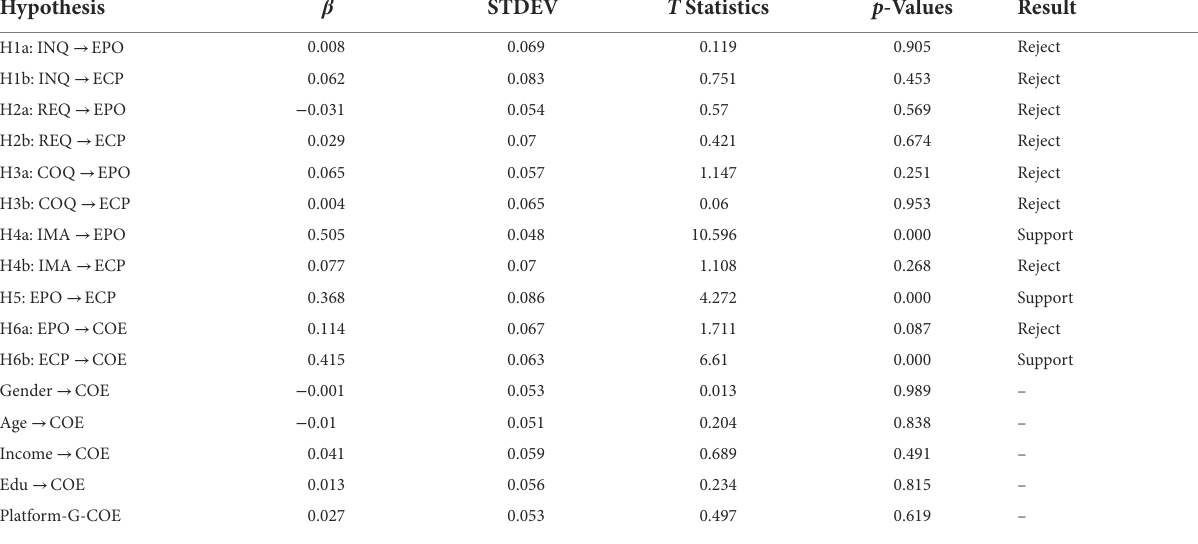
TABLE 3 Assessment of the structural model. Hypothesis β STDEV T Statistics p -Values